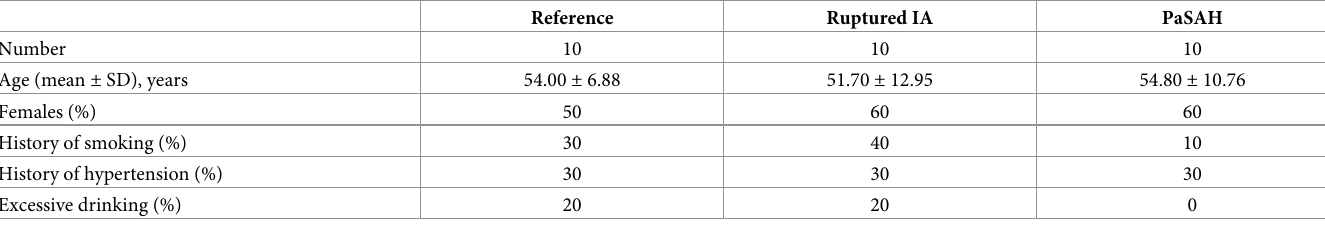
Table 1. Clinical characteristics of the patient groups who provided blood samples for qRT-PCR analysis.